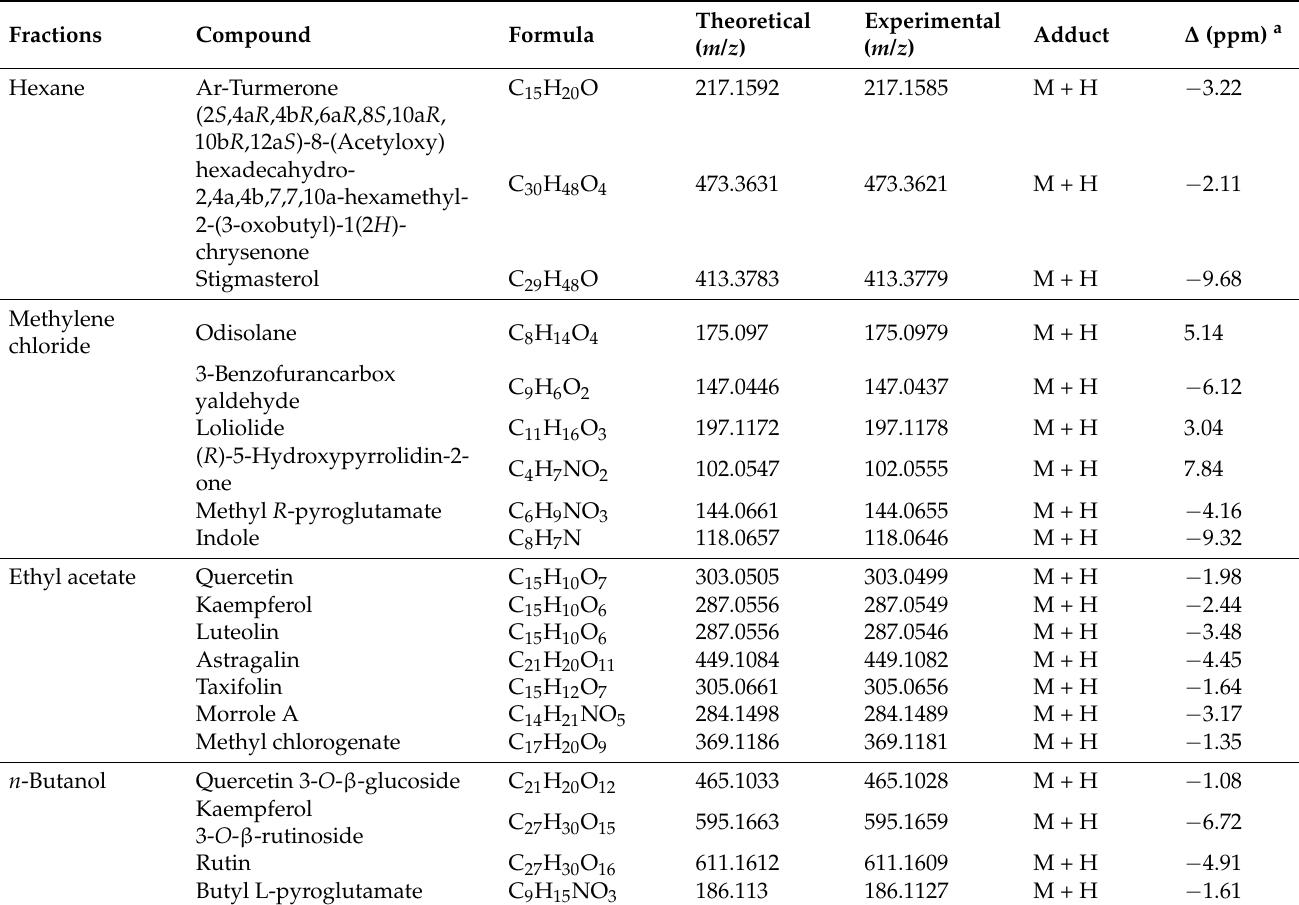
a Deviation of measured m / z from calculated m / z values for a pseudomolecular ion generated from the molecular